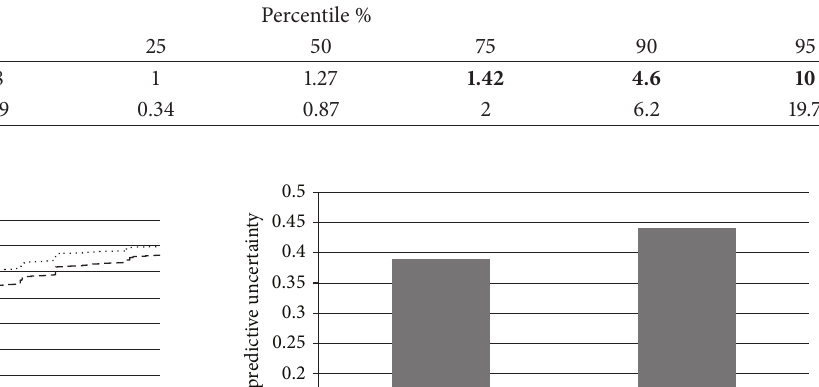
Table 6: Percentile of absolute error value between observed and simulated flow (CMS).